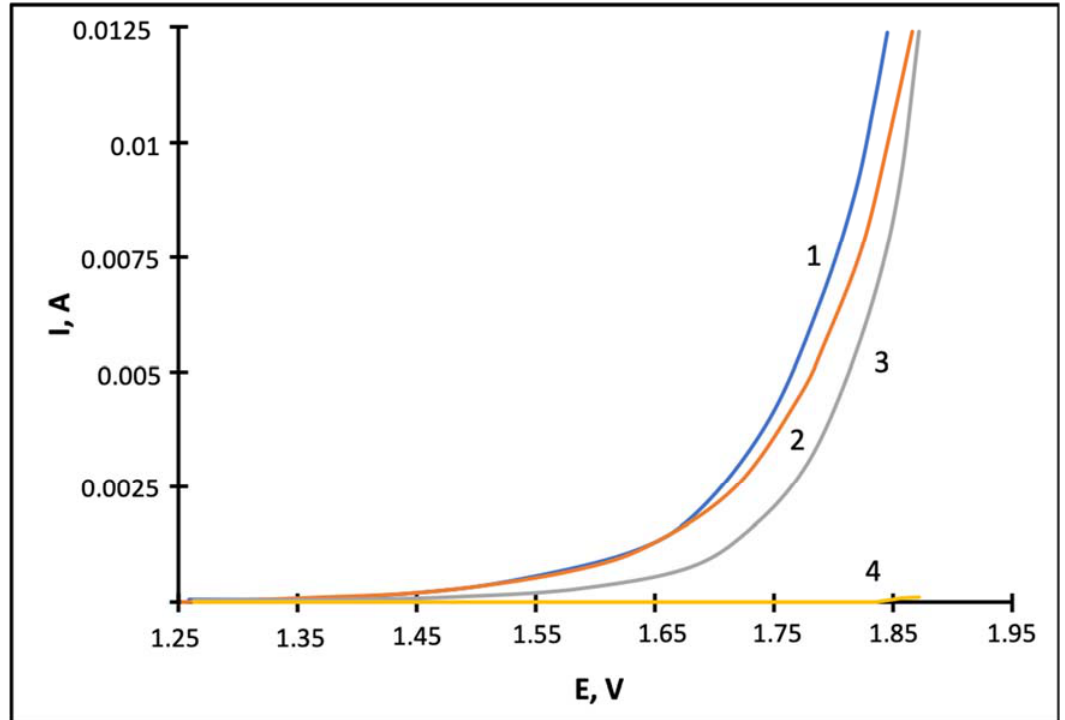
Figure 8. Polarization curves for smooth titanium electrodes with coatings obtained in the DC sputtering mode recorded in an aqueous solution of 1M of sulfuric acid at temperature 25 °C (scan rate 0.1 mV/s). Curve 1—Pt-C target was sputtered; curve 2—Pt target was sputtered. Curve 3—Pt foil and curve 4—smooth titanium are given for comparison.